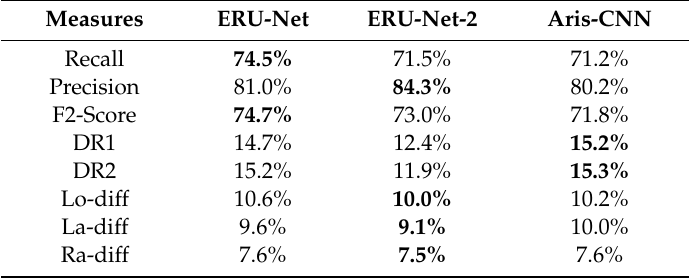
Table 2. Recognition results of different network models on 5000 training images (bold in the table means the best results on this evaluation index).